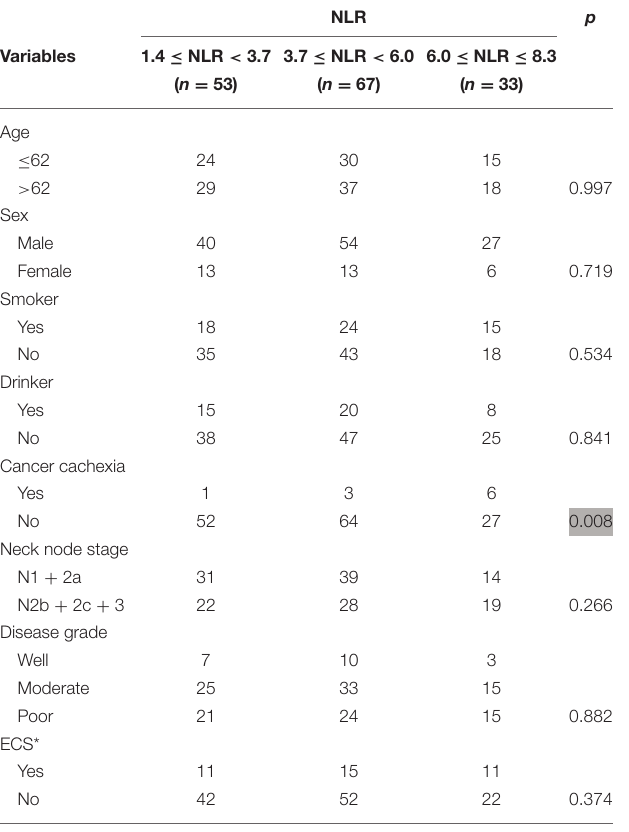
TABLE 1 | Association between neutrophil-to-lymphocyte ratio (NLR) and clinical pathologic variables in patients with squamous cell carcinoma of unknown primary. NLR p